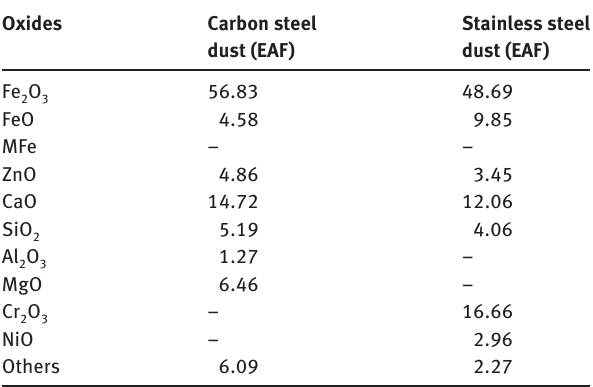
Table 1: Chemical compositions of EAF dusts (mass%) Oxides Carbon steel